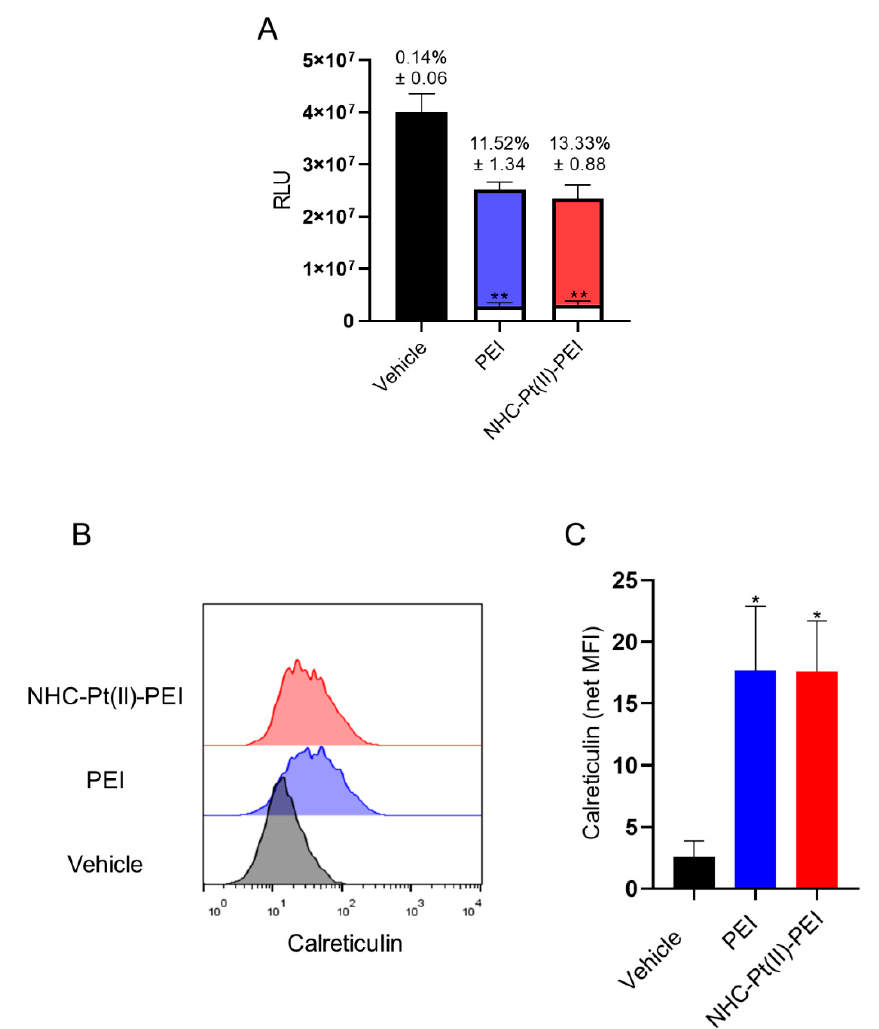
Figure 10. DAMPs release of 6 h 5 µ M NHC-Pt(II)-PEI and 5 µ M PEI eq treated NCH421K spheroids. ( A ) Overlapped histograms of ATP generated RLU using the CelltiterGlo 3D viability assay measured on the cellular supernatant (white) and the total well contents (cells + supernatant) (coloured) following treatment. The numbers above represent the percentage of ATP found in the supernatant relative to the total well contents. Values represent the mean of at least n = 3 independent experiments ± one SEM. Statistics represent Student’s t-tests vs. the corresponding vehicle reference. Distribution normality was confirmed using a Shapiro–Wilk test. ** = p ≤ 0.01. ( B ) Representative flow cytometry histograms (FlowJo v10) of treated live-gated (PI-) cells stained for calreticulin. ( C ) Histograms of net MFI (median) (MFI condition – MFI isotype control) of treated cells. Values represent the mean of at least n = 3 independent experiments ± one SEM. Statistics represent Student’s T-tests vs. the corresponding vehicle reference. Distribution normality was confirmed using a Shapiro–Wilk test. * = p ≤ 0.05.